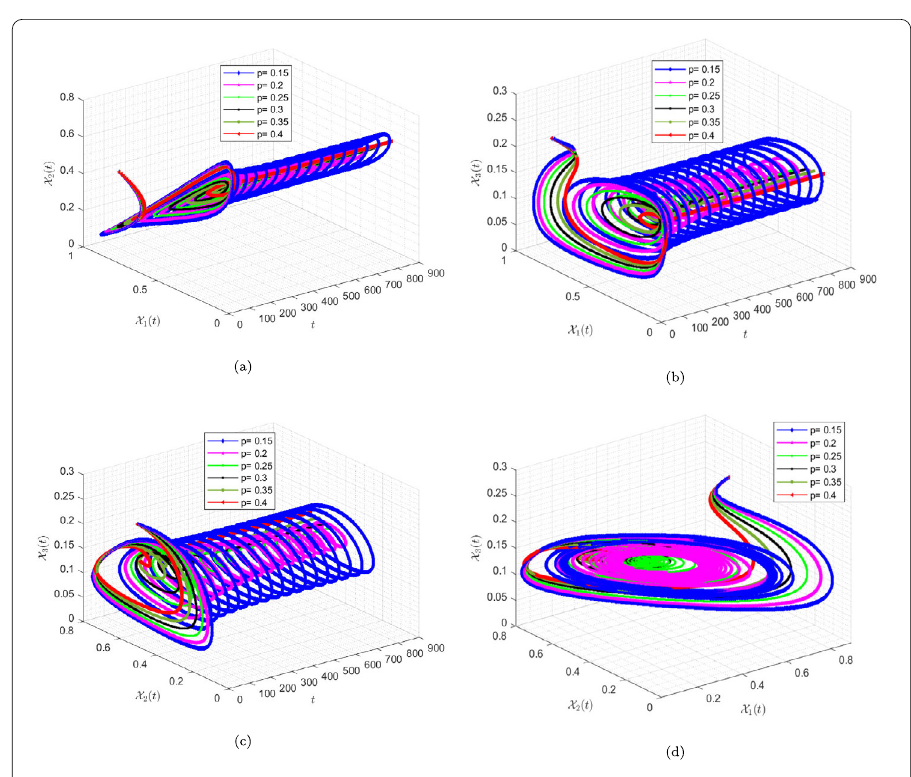
Figure 12 Dynamics for system (19) by taking different values of parameter p